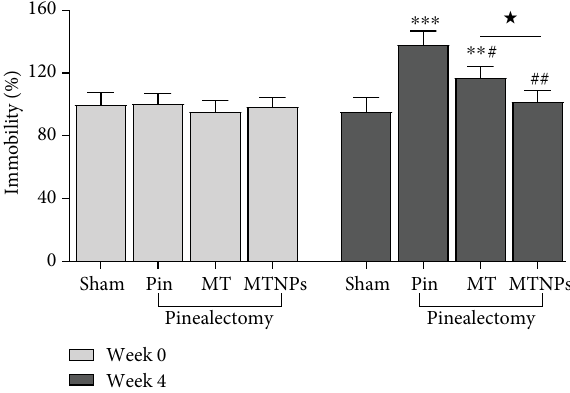
Figure 6: E ff ect of melatonin-loaded nanoparticles (MTNPs) on saccharin preference. ∗∗∗ P < 0 : 001 vs. the sham group; # P < 0 : 05 and ## P < 0 : 01 vs. the Pin group. Pin: pinealectomized rats; MT: melatonin.